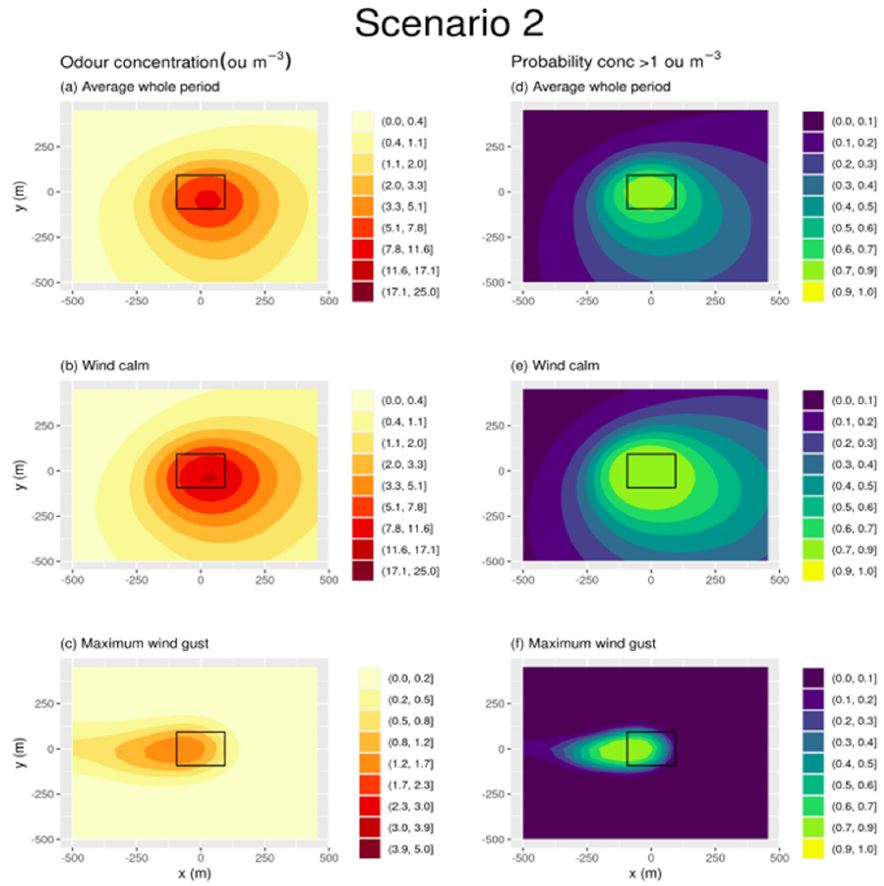
Figure 10. Odour concentrations (left panel) and exceedance probability of the 1 ou m − 3 threshold (right panel) at a 1.7 m height as simulated by SCICHEM for the period 1 October 2020–31 October 2020, for scenario 2. Modeled concentrations and probabilities are represented for the whole period ( a , d ), the episodes of calm winds ( b , e ), and the episode of maximum wind gust ( c , f ). The square in the center represents the fertilized field (emission source), and the x and y coordinates are expressed as the distances in meters from the center of the source. Note: the color scales are the same as for scenario 1, with those for the concentrations in the maximum wind gust event being different from the other two cases (average conditions, wind calm conditions).